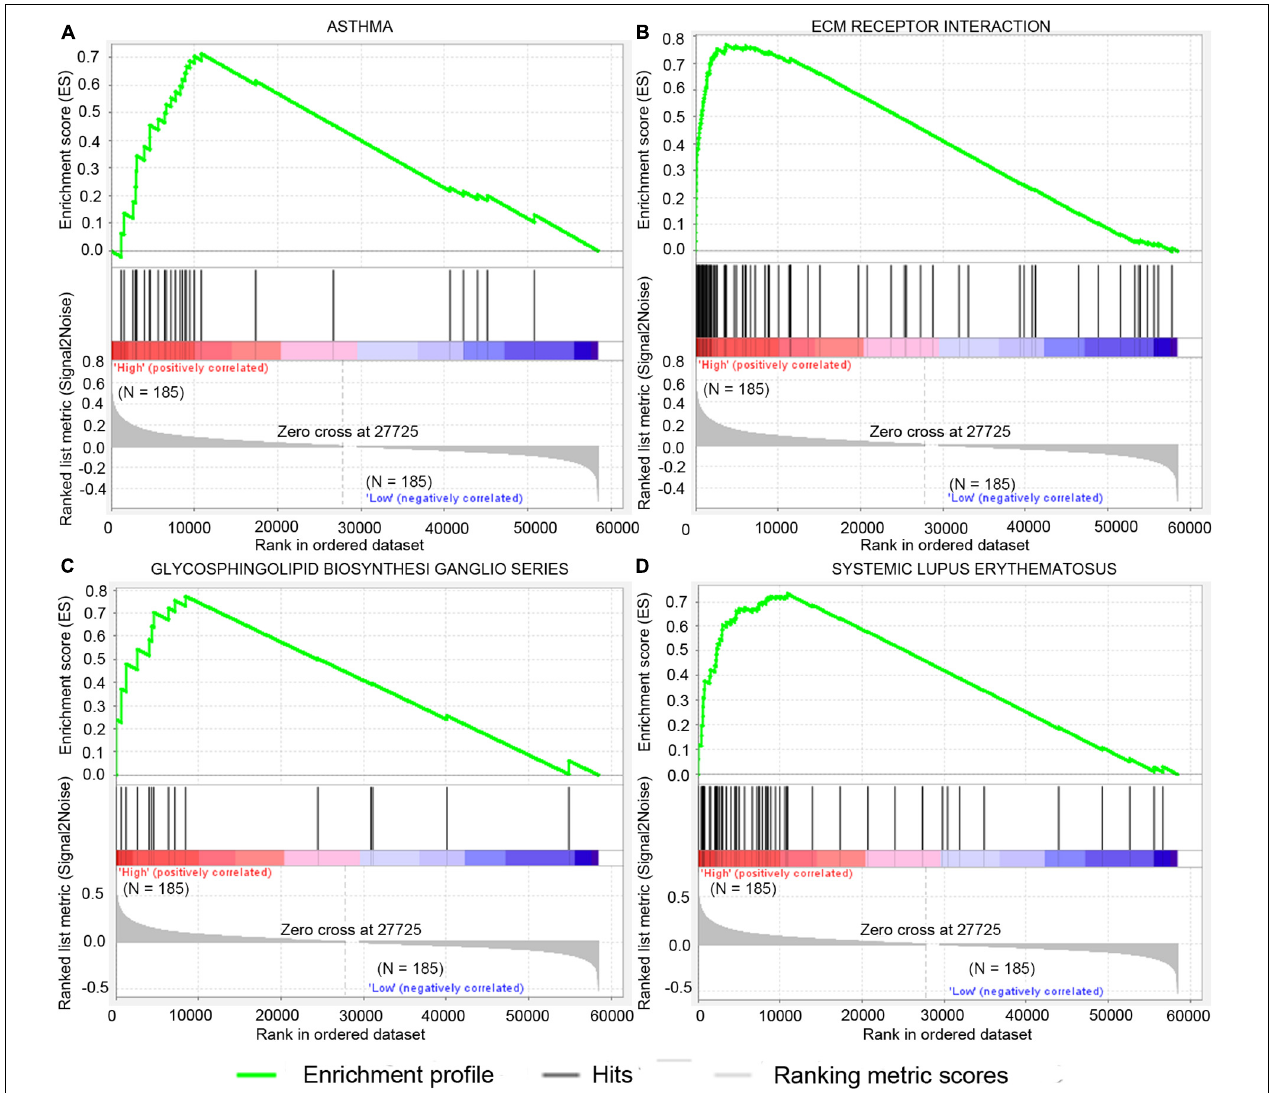
FIGURE 7 | Significantly enriched signal pathway in patients with high risk compared with patients with low risk in the TCGA dataset. The significantly enriched KEGG pathways include asthma (A) , ecm receptor interaction (B) , glycosphingolipid biosynthesis ganglio series (C) , and systemic lupus erythematosus (D)